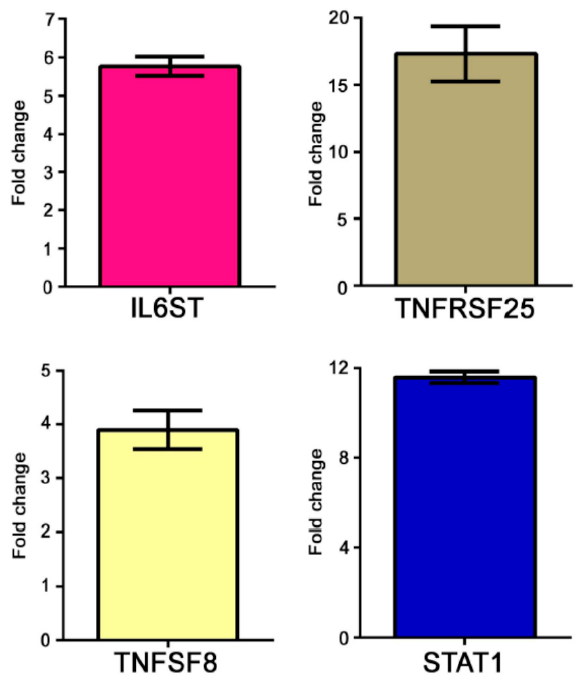
Figure 1. Real time (RT)-PCR of some modulated genes in AS patients. Genes selected for validation were IL6ST, TNFRSF25, TNFSF8 and STAT1. The transcripts of the selected genes were increased in AS samples when compared to healthy donors. Relative expression levels were calculated for each sample after normalization against the housekeeping gene GAPDH. Experiments have been conducted in triplicates. Similar results were obtained using the housekeeping genes18s rRNA and beta-actin.